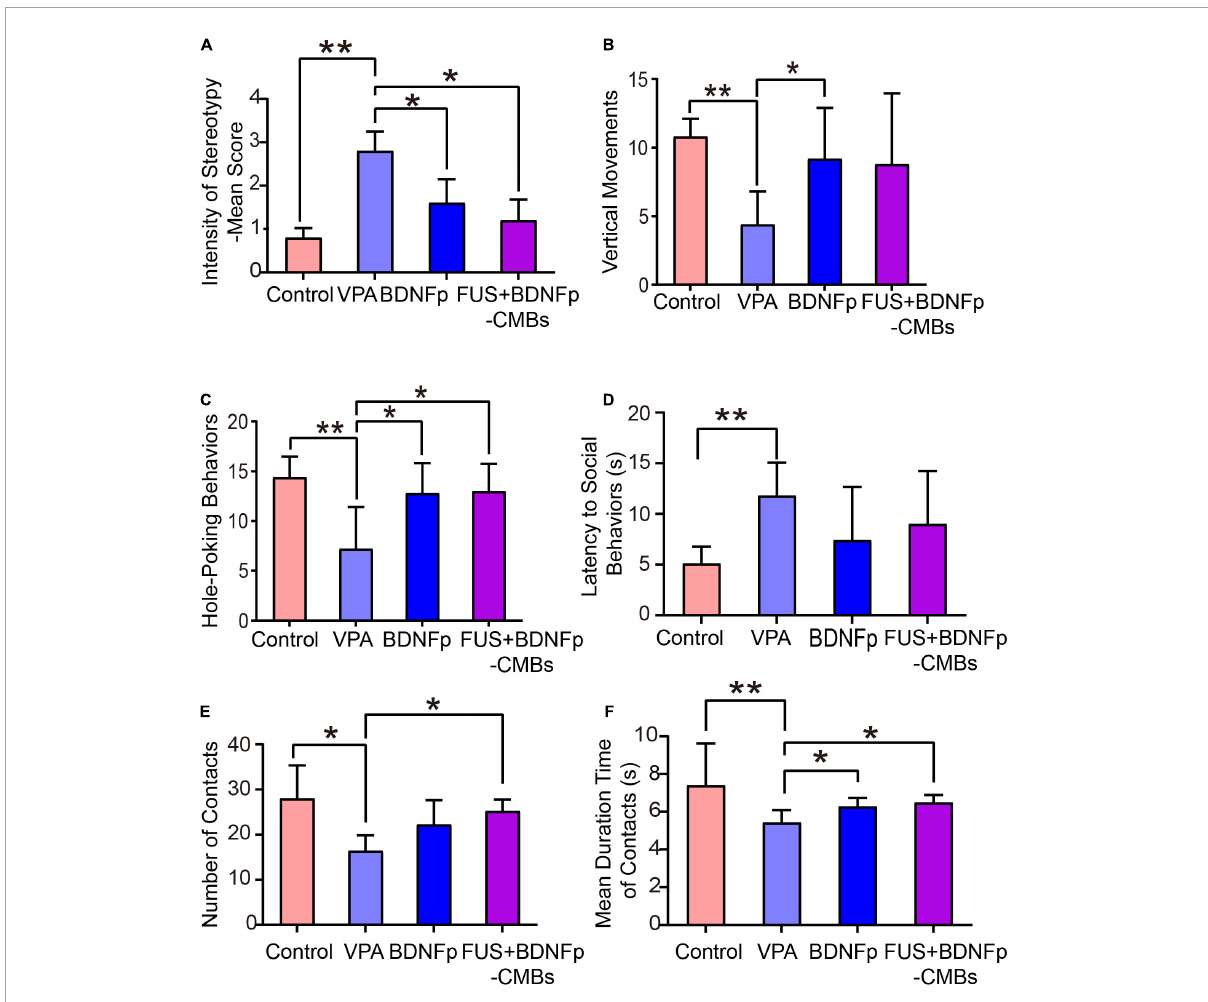
FIGURE5 Behavioral evaluation of autistic rats treated with FUS combined with BDNFp-CMBs. (A) The stereotyped behavior scores of the rats in the four groups. (B) The standing times of rats in the four groups. (C) The times of “nose contact hole exploration” of the rats in the four groups. (D) The social behavior latency of the rats in the four groups. (E) The contact times of the rats in the four groups. (F) Contact durations of the rats in the four groups. Con, Control group; VPA, Autism rat model group; BDNFp, Direct injection of the BDNFp group. FUS + BDNFp-CMBs: FUS combined with the BDNFp-CMBs group. The data in (A–C,E) were analyzed using non-parametric Kruskal-Wallis tests with Dunn’s multiple comparisons. The data in (D,F) were analyzed using one-way ANOVA with Tukey’s multiple comparisons. * p < 0.05, ** p <